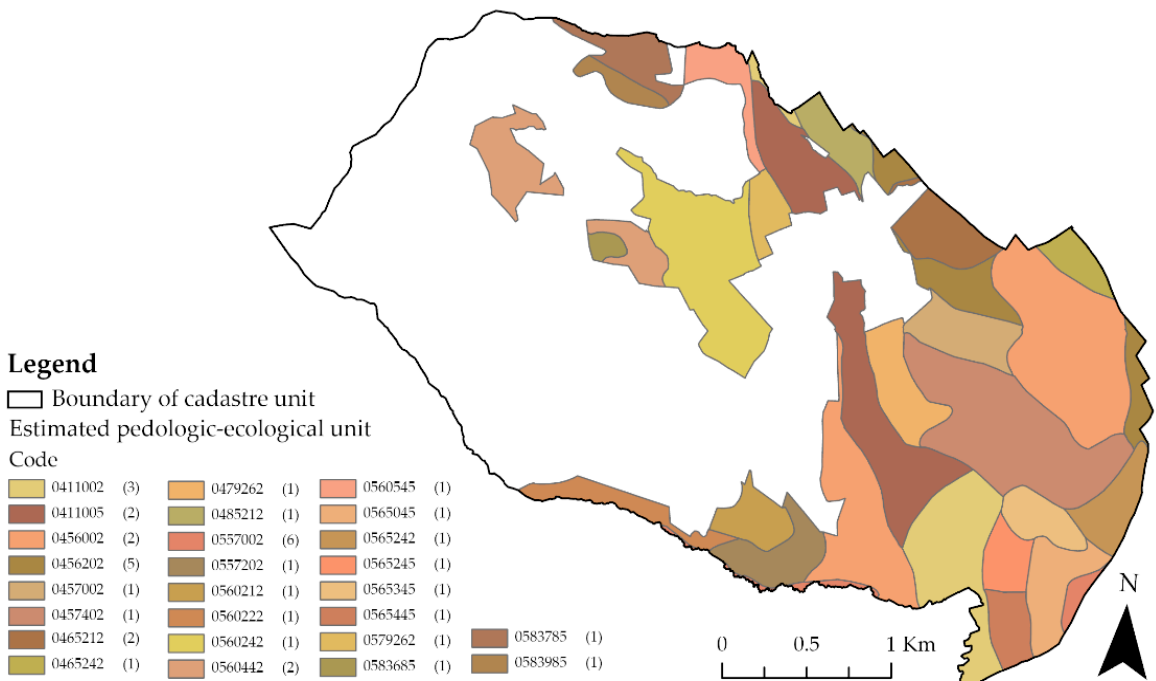
Figure 12. Estimated pedologic-ecological units in the cadastral unit Podre č any.